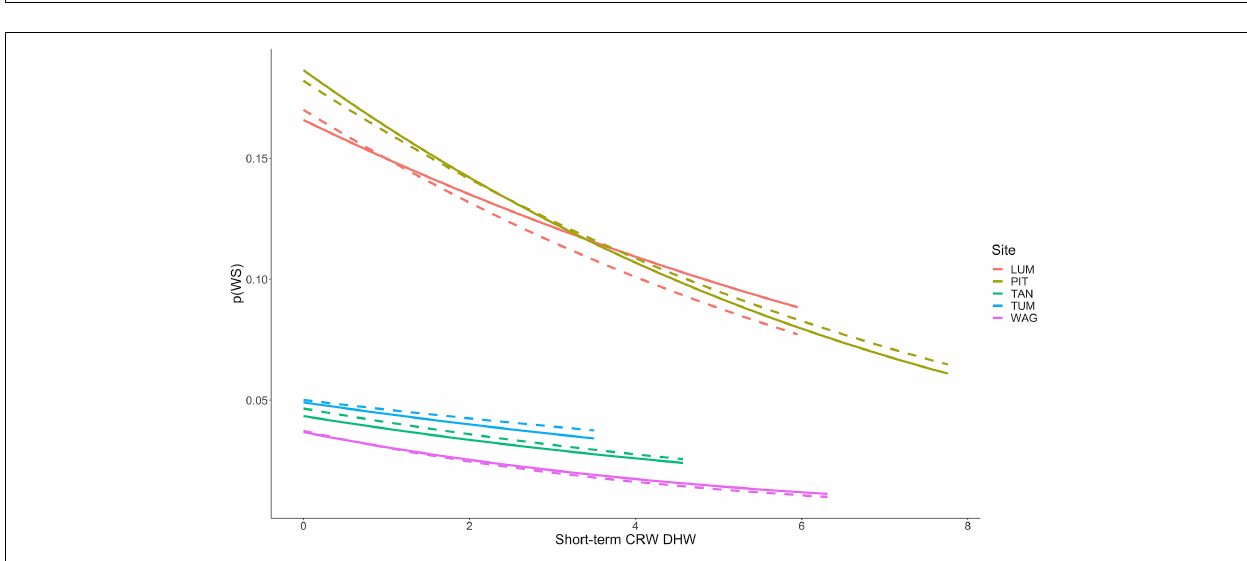
FIGURE 6 | Decreasing probability of White Syndrome with increased Degree Heating Week values. Solid lines represent predicted White Syndrome probability on training data, dashed lines represent predictions for reserved data. Species-level plots in Supplementary Figure 8